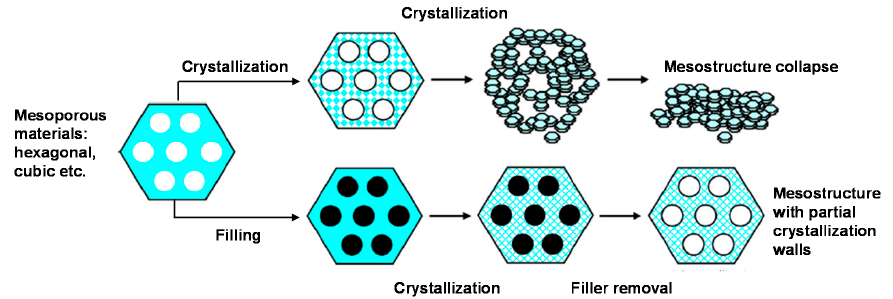
materials in the steam assisted crystallization (SAC) process for preparation of MZCs [82]. Parts of this figure were published in Catal. Today, Vol. 168, Ogura, M.; Inoue, K.; Yamaguchi, T., A mechanistic study on the synthesis of MCM-22 from SBA-15 by dry gel conversion to form a micro- and mesoporous composite, pp. 118–123, Copyright Elsevier